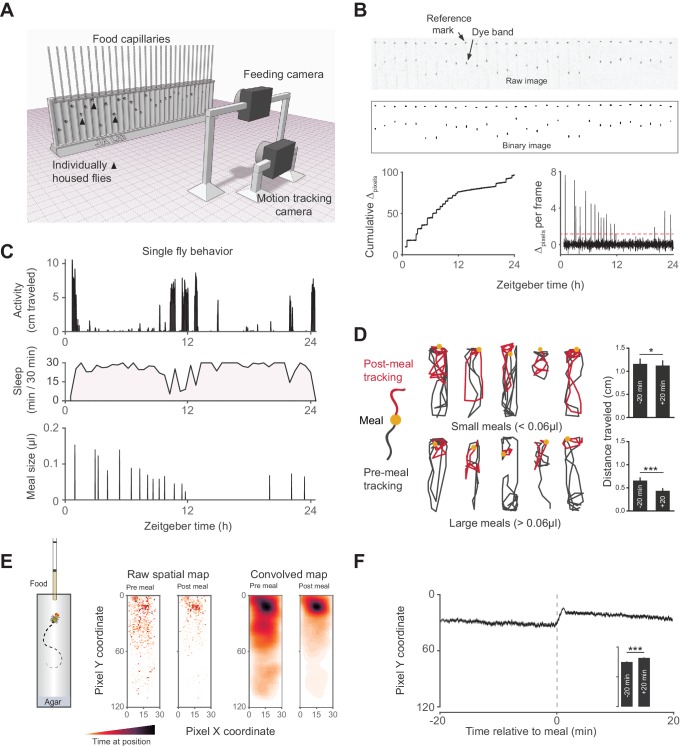
Activity Recording CAFE (ARC) facilitates simultaneous, high resolution measurements of food intake and motion in individual flies.(A) Schematic of ARC apparatus. Independent computer-controlled cameras record images of capillaries for feeding measurements and of flies for activity and sleep determination. (B) Raw image (one out of 1440 taken over 24 hr) of capillaries containing liquid food (top). Capillaries have an external reference mark and an internal dyed oil band overlaid the aqueous food. Images are thresholded to binary, from which cumulative pixel distances between the reference mark and dye band can be calculated from the image series (bottom). Δpixels per frame reveals individual feeding events, selected as events greater than 3.5 standard deviations above noise (red dashed line). (C) Activity, sleep (black shading) and feeding (µl) of an individual fly (activity and feeding in 1 min bins, sleep in 30 min bins). (D) Example motion traces of individuals before (black) and after (red) a meal (yellow circle). Motion traces and averages associated with small (<0.06 µl) or large (≥0.06 µl) meals are shown. n = 661 meals from 30 flies, w1118; *p<0.05, ***p<0.001, Wilcoxon matched-pairs sign rank test. (E) Raw and convolved spatial heat map showing time spent at each pixel coordinate in the 20 min before and after meals (291 feeding events from 15 w1118 flies, Gaussian convolution). (F) Kymograph of average vertical position in time relative to meals (shaded line represents mean ± s.e.m.). The inset graph shows the average position over 20 min pre-meal (−20) and post-meal (+20) with the axis scaled to the parent graph. ***p<0.001, Wilcoxon matched-pairs sign rank test. All bars represent mean ± s.e.m.